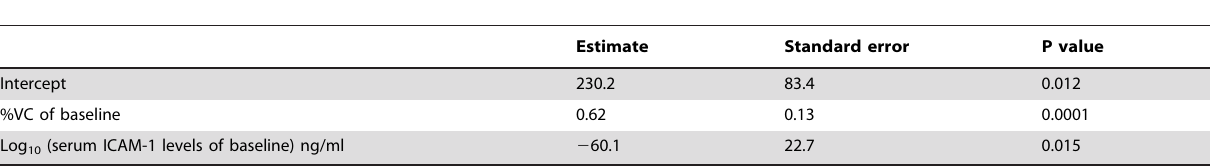
Table 5. Factors predicting %VC of 4 year follow-up determined by multiple regression